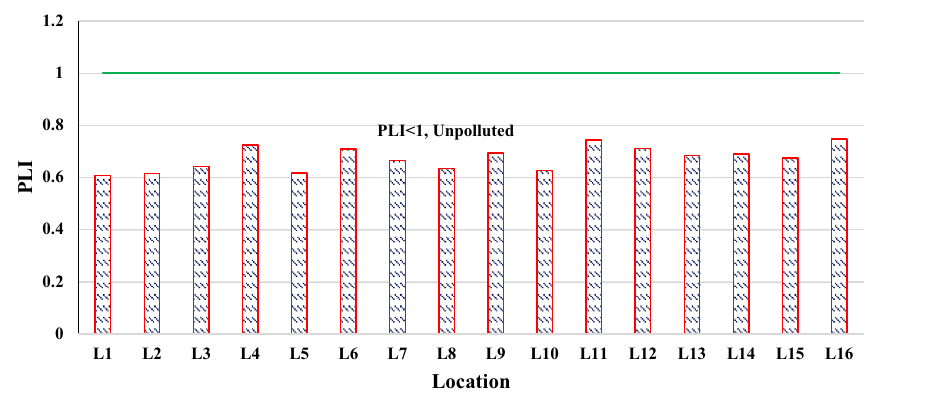
Figure 6. PLI values for TEs in the soils of